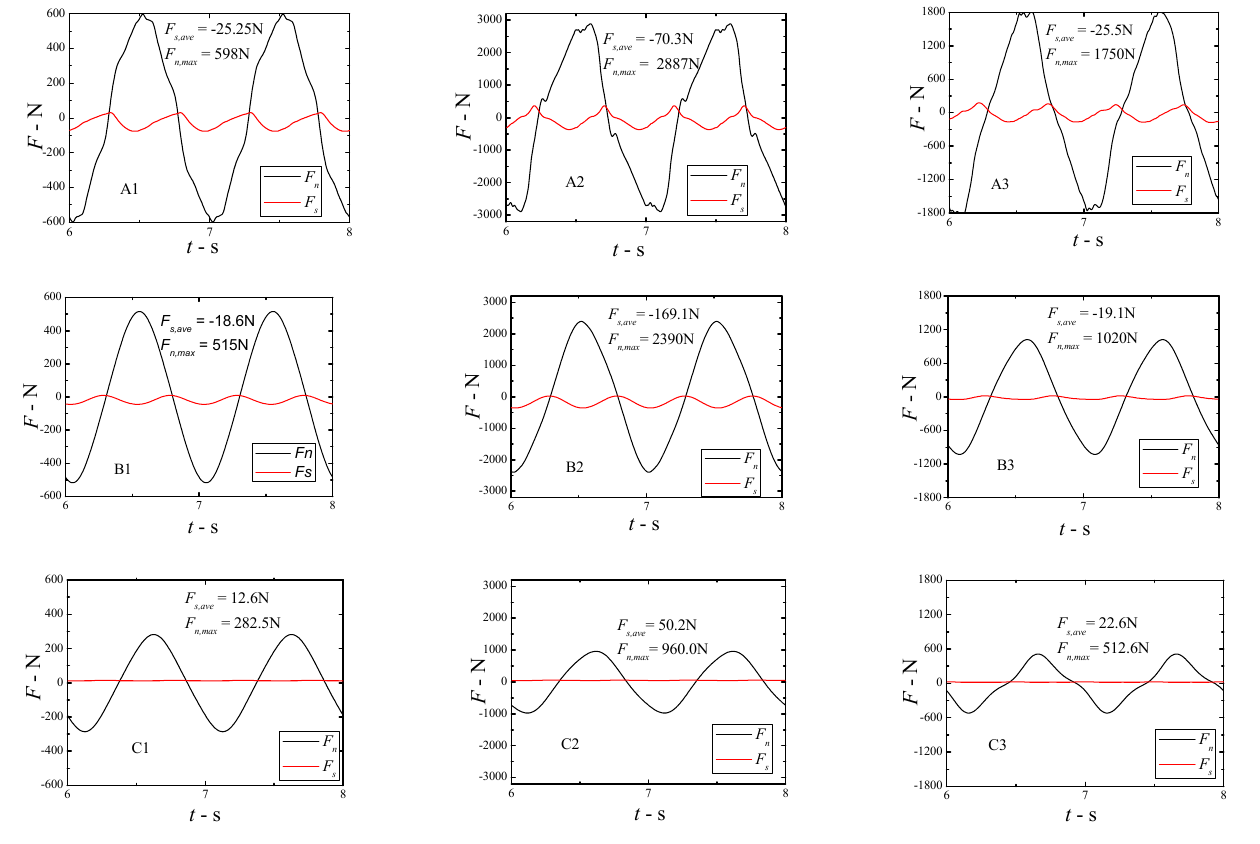
Figure 25. Comparison of Fs and Fn at nine working points.